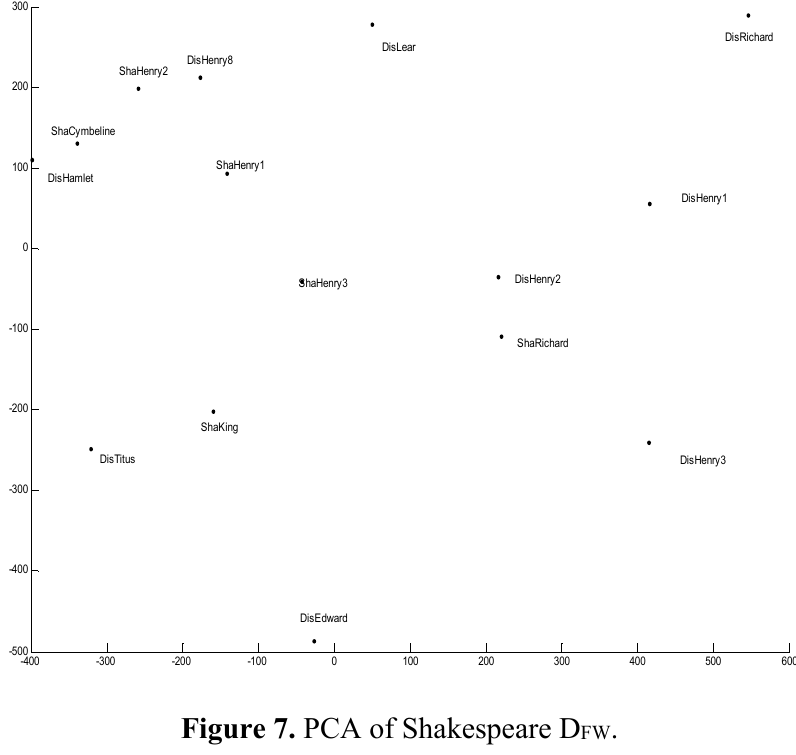
Figure 7. PCA of Shakespeare D FW